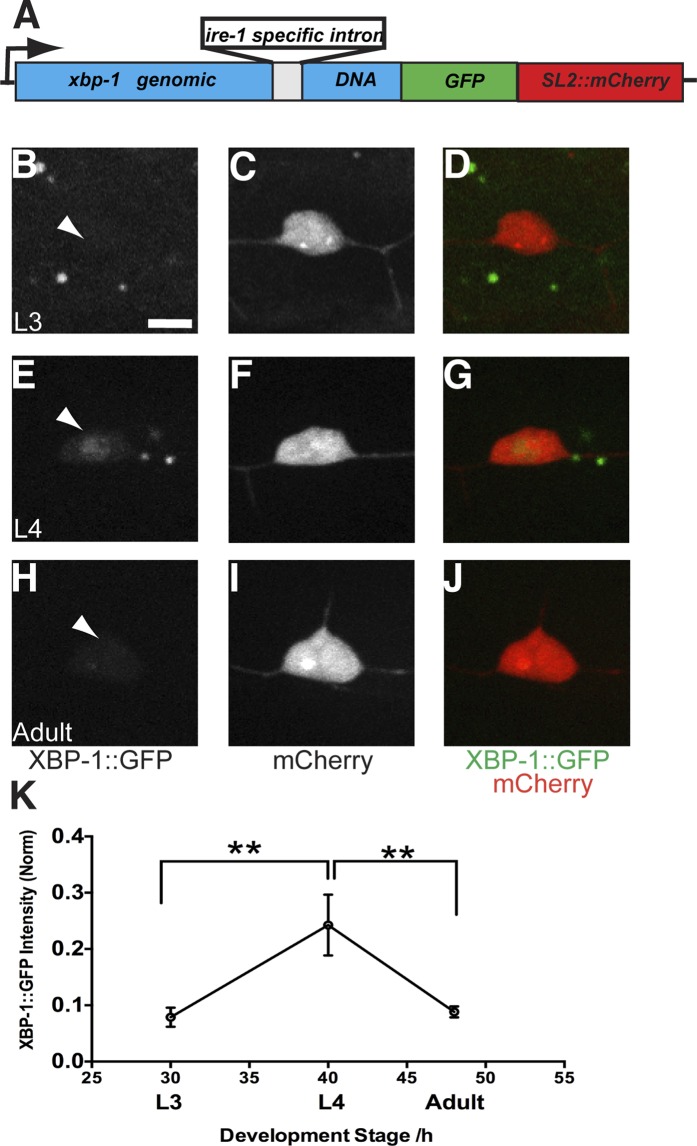
The UPR activity is correlated with dendritic branching during development in the PVD neuron.(A) Design of the PVD-specific UPR activity reporter. The xbp-1 genomic DNA is fused with GFP followed by an SL2::mCherry cassette, which permits the bicistronic expression of XBP-1::GFP and mCherry. The reporter is driven by a PVD specific promoter. The XBP-1::GFP brightness indicates the UPR activity while the intensity of mCherry is used to normalize to transgene expression levels. (B to J) The PVD UPR activity in L3 stage (B to D), L4 stage (E to G) and adult stage (H to J). Arrowheads, nuclei of PVD. Scale bar, 5 μm. (K) Quantification of the normalized UPR activity in PVD in (B to J). Error bars show mean ± s.e.m. n = 30–50. **p < 0.01, Kruskal–Wallis one-way test and post hoc Dunn's test.